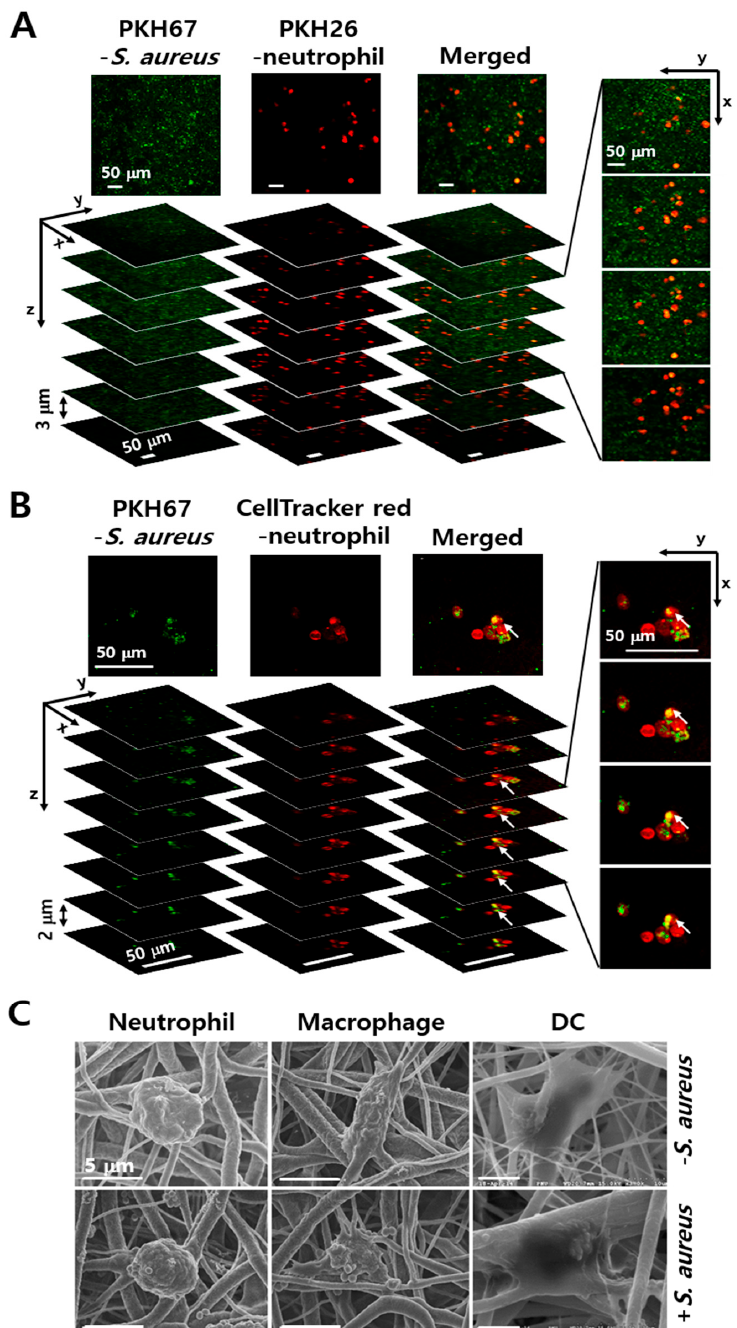
Figure 2. Co-culture of phagocytes and S. aureus in the PCL-NM. ( A , B ) Peritoneal neutrophils were labeled with PKH26 ( A ) and CellTracker red ( B ). The labeled neutrophils (1 × 10 5 ) and PKH67-labeled S. aureus (1 × 10 6 CFU) were top-seeded on the PCL-NM and cultured for 1 h in the membranes ( n = 3). Co-localization of neutrophils and bacteria was evaluated by focus-stacking images of the PCL-NM. Images of 3 µm ( A ) and 2 µm ( B ) in thickness from the top to bottom are shown. Arrows indicate green-fluorescent spots inside of red-fluorescent areas. ( C ) Neutrophils, macrophages and DCs (1 × 10 5 ) were top-seeded on the PCL-NM and cultured with (+) or without ( − ) S. aureus (1 × 10 6 CFU) for 1 h in the PCL-NM. The localization of S. aureus and phagocytes in the PCL-NM was evaluated by SEM. Data are representative of three independent experiments.